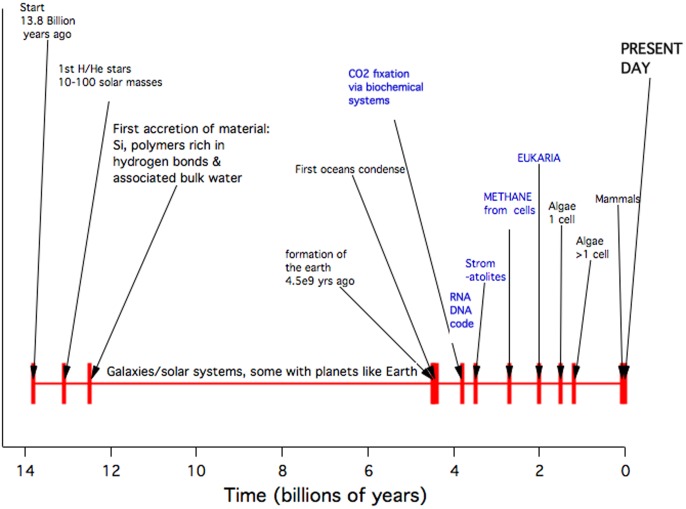
Chemical Time Line.